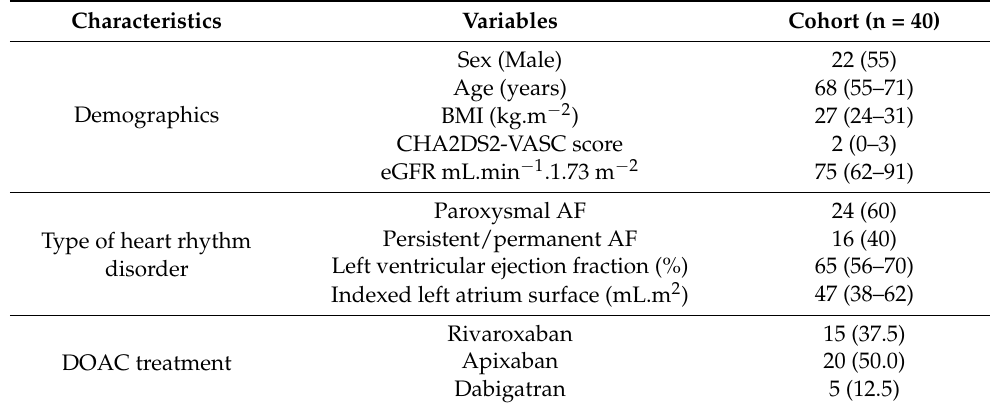
Table 1. Patient characteristics, anticoagulant treatment, and type of heart rhythm disorder. Continuous variables are expressed as median [interquartile range] and categorical variables by n (%). BMI = body mass index; eGFR = estimated glomerular filtration rate; DOAC: direct oral